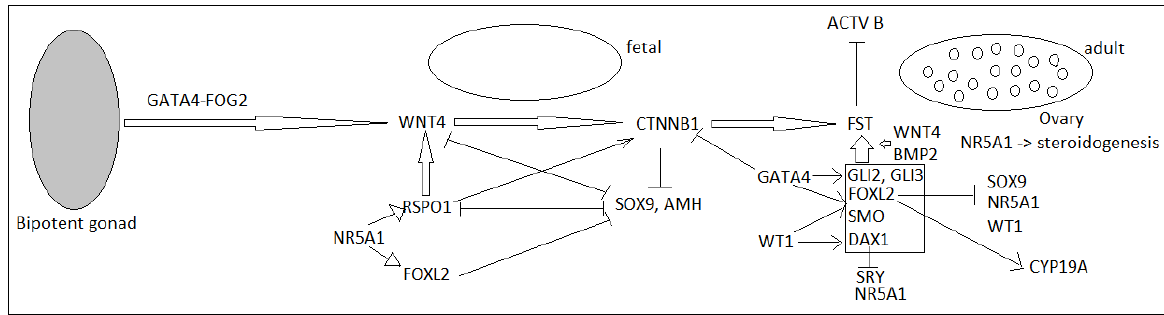
Figure 3. Molecular factors involved in ovary development [29].